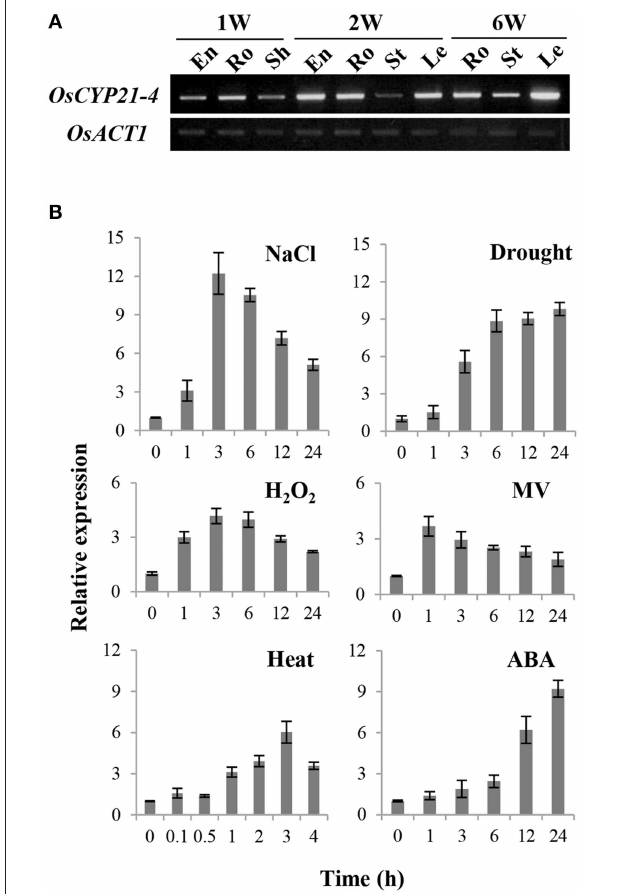
FIGURE 3 | Expression of OsCYP21-4 in rice. (A) Expression levels of OsCYP21-4 in different tissues and stages by semi-quantitative RT-PCR analysis. 1 W, 1-week-old; 2 W, 2-week-old; 6 W, 6-week-old; En, endosperm; Ro, root; Sh, sheath; St, stem; Le, leaf; OsACT1 , rice actin1. OsACT1, rice actin1. OsACT1 was used as an internal control for mRNA quantification. (B) Expression levels of OsCYP21-4 in 2-week-old